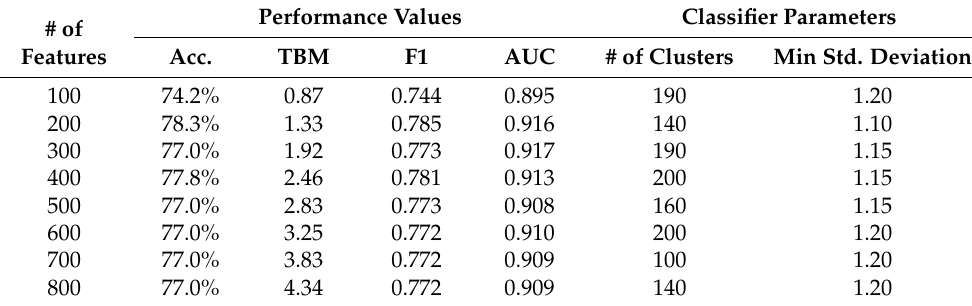
Table 9. The best performance of RBFN over different feature